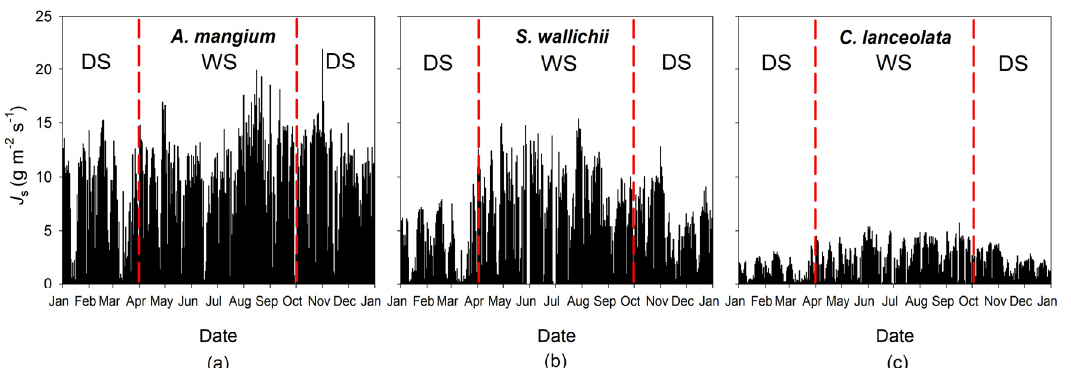
Figure 3. Daily mean J s averaged for all the sap flow-monitored trees in each plot during dry season (DS) and wet season (WS). ( a ) A. mangium site; ( b ) S. wallichii site; ( c ) C. lanceolata site.